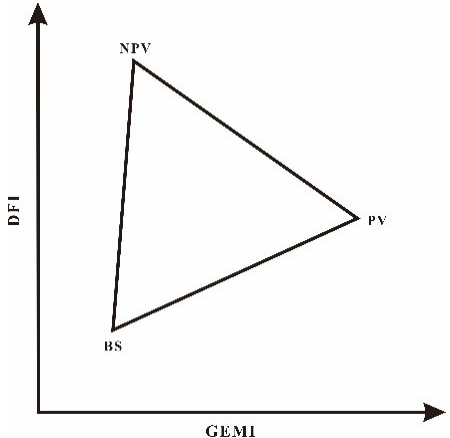
Figure 4. The conceptual model of the global environment monitoring index and cellulose absorption index (GEMI-CAI) relation triangle of the PV, NPV and BS.